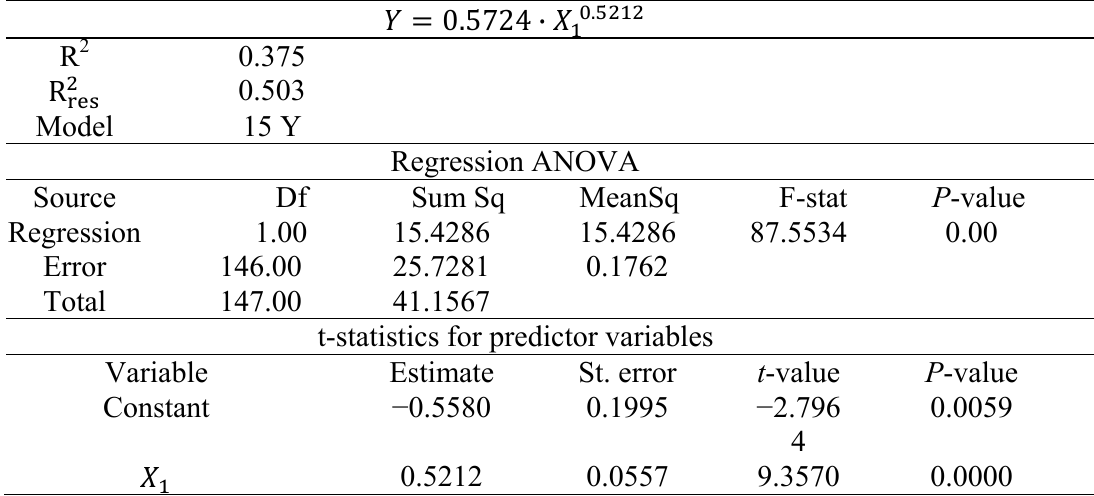
Figure 24a. It is expected that better measurements of traits and more replications conducted in the same field year after year will eventually lead to model fits significantly better. Table 8. ANOVA results for Model 15Y of Table 5.